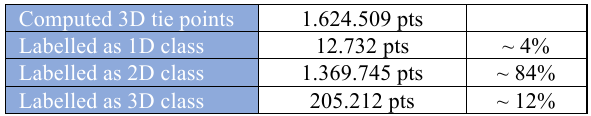
Table 2: 3D tie points of the Modena datasets labelled as belonging to the 1D, 2D, 3D class.